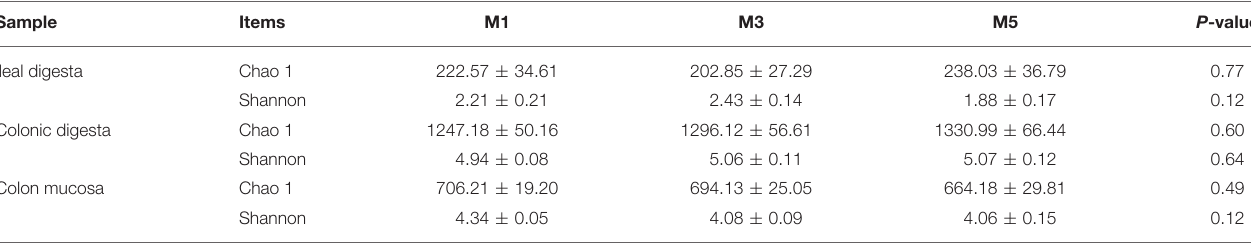
TABLE 1 | Richness estimators and diversity indices of the 16S rRNA gene libraries in ileal digesta, colonic digesta, and colon mucosa of pigs with different feeding frequencies a .